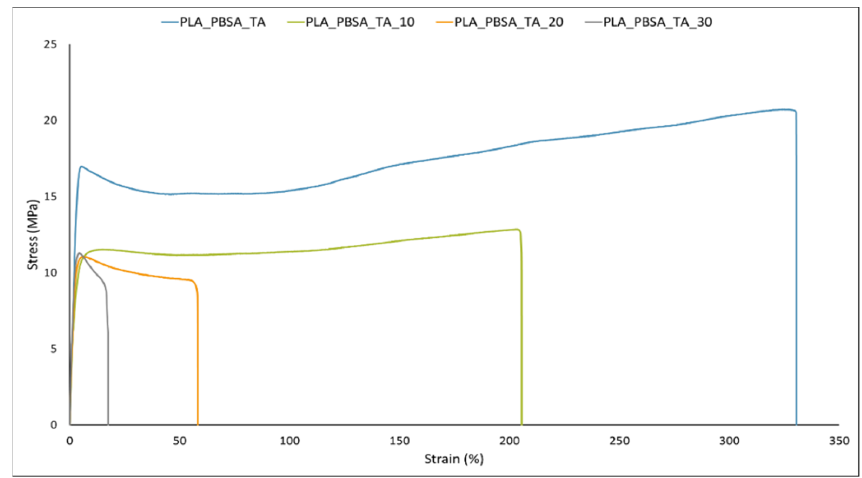
Figure 4. Stress-strain representative curves for plasticized PLA/PBSA composites. The decrease in the stress at break with bran content is ascribable to a low adhesion between the matrix and the fibers that causes an ineffective transmission of the load from the matrix to the fibers. The application of the analytical models for stress at break (Figure 5a) confirms that low adhesion exists between the wheat bran and the polymeric matrix. The experimental data lies exactly between the lower and upper bound confirming the good applicability of the analytical models to the analyzed system.